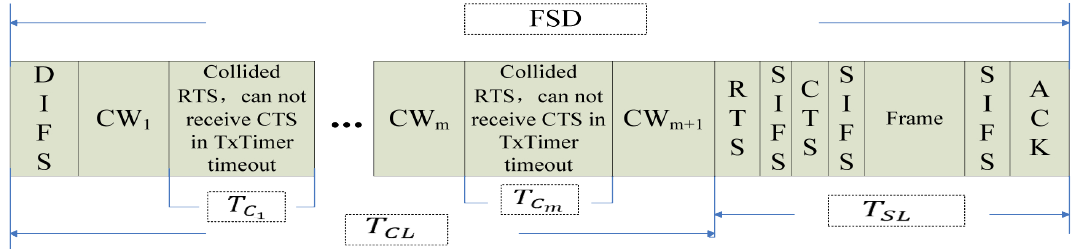
Figure 1. The delay of RTS/CTS (Request To Send/Clear To Send) mechanism.